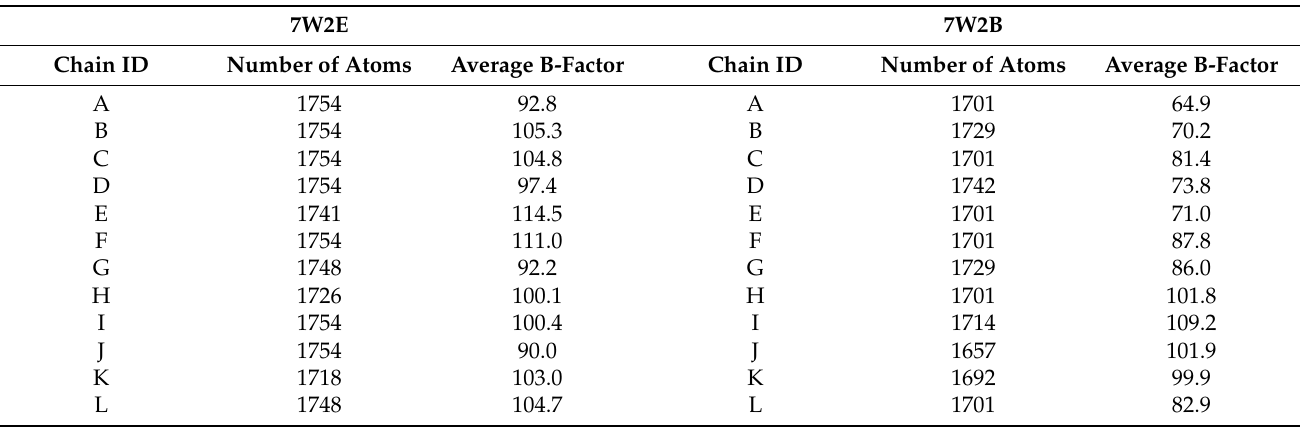
Table 5. Average B-factor values of all monomers of the Xl σ 1-R structures in coordinate files 7W2E (apo form, open conformation) and 7W2B (apo form, closed conformation).